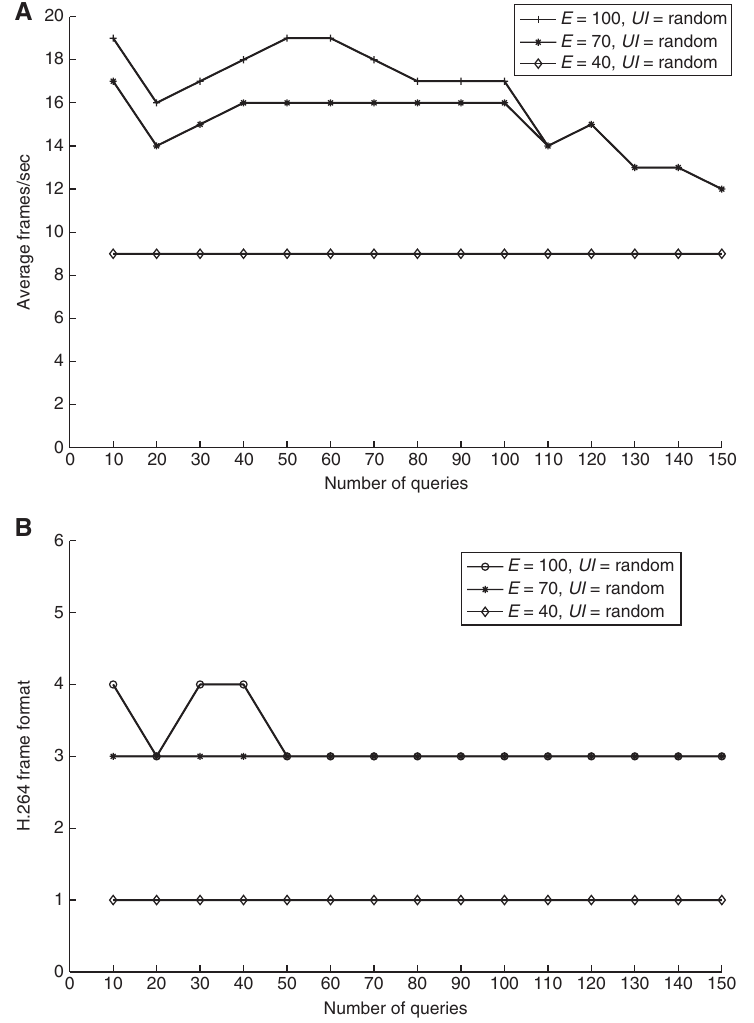
Figure 5: Average Frames/Second and H.264 Frame Format for Random user Inputs and Constant Node